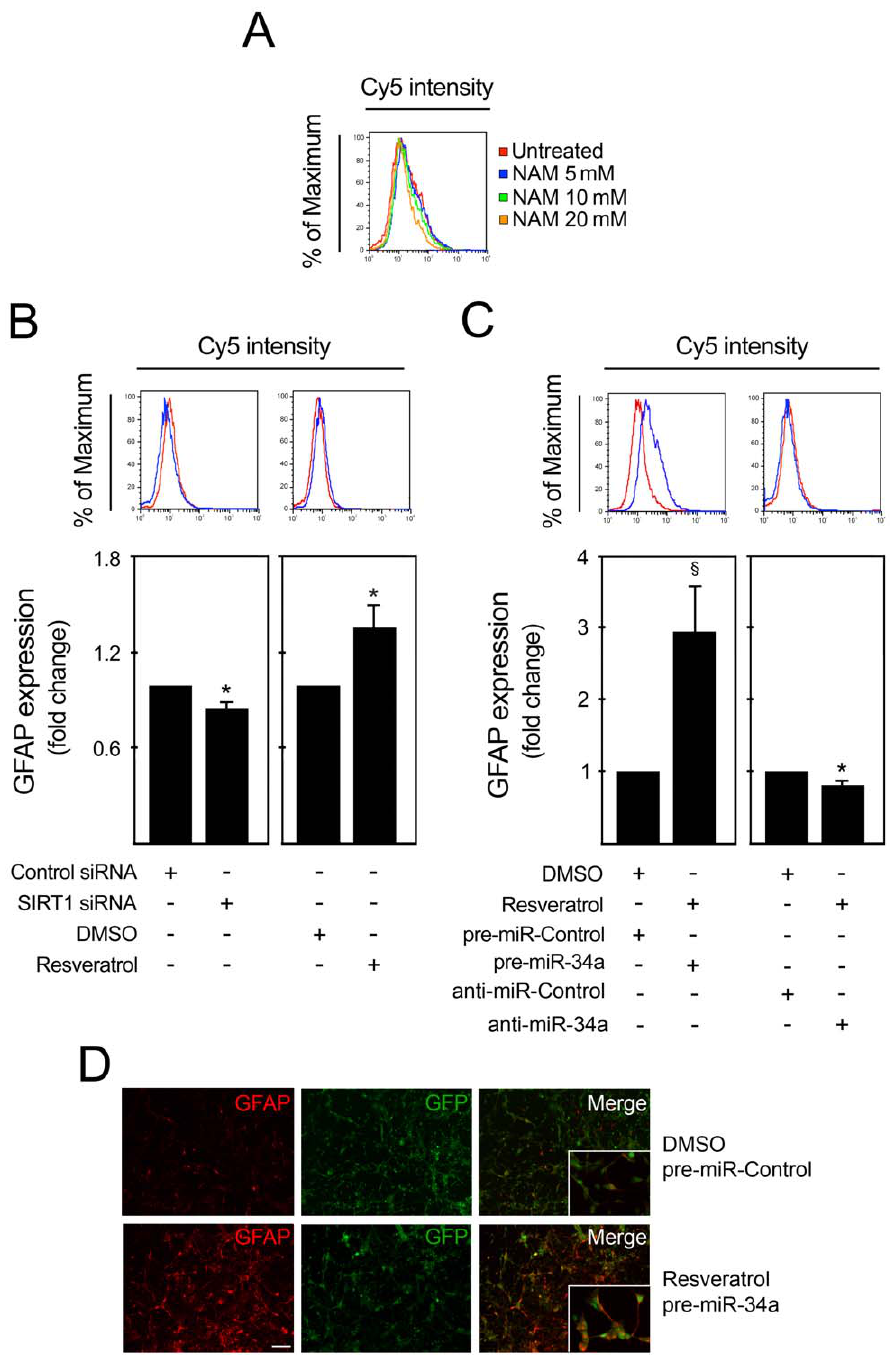
Figure 5. miR-34a promotes astrocytic differentiation under resveratrol treatment. SIRT1 expression was modulated in mouse NS cells after 12 h of induction of differentiation. Inhibition of SIRT1 was achieved by incubation with nicotinamide or by transfecting cells with either scrambled control or 100 nM of SIRT1 siRNA. SIRT1 was activated by treating cells with either DMSO (control) or 5 m M of resveratrol. Cells were collected at 3 days, fixed and processed for GFAP labeling and detection by flow cytometry and immunofluorescence. The blue line corresponds to SIRT1 modulation, while the red line represents the respective control. A. Incubation with nicotinamide, decreased the percentage of GFAP + cells in a dose-dependent manner. B. Decreased percentage of GFAP + cells after silencing of SIRT1 ( left ), and increased percentage of GFAP + after SIRT1 activation ( right ). C. Under resveratrol treatment, overexpression of miR-34a resulted in increased proportion of GFAP + cells ( right ), while miR-34a downregulation had the opposite effect ( left ). D. Immunofluorescence showing increased number of GFAP + cells under resveratrol treatment and miR-34a overexpression ( bottom ) when compared with controls ( top ). Scale bar, 80 m m. Images taken with a magnification of 400 6 are shown in detail. * p , 0.05 and 1 p , 0.001 from cells transfected with respective control. NAM, nicotinamide.